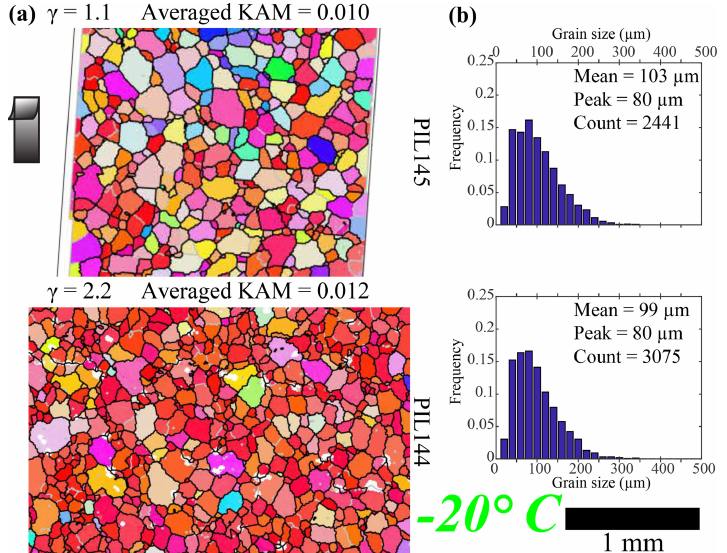
Figure 6. Microstructure of the shear planes of samples deformed at − 20 ◦ . Strain increases from top to bottom. (a) Orientation maps colored by the crystallographic orientation normal to the shear plane according to the color map at bottom right. Step size is 10µm (see Table 2, columns 5–7). Grain boundaries, characterized by a misorientation of 10 ◦ , are black, and subgrain boundaries, characterized by a misorientation of 2 ◦ , are gray. Un-indexed spots are white. The shear direction on the top side is up, as shown by the black arrow. Maps are subareas of the whole mapped area. The whole mapped area was used to calculate KAM and grain size. (b) Distributions of grain